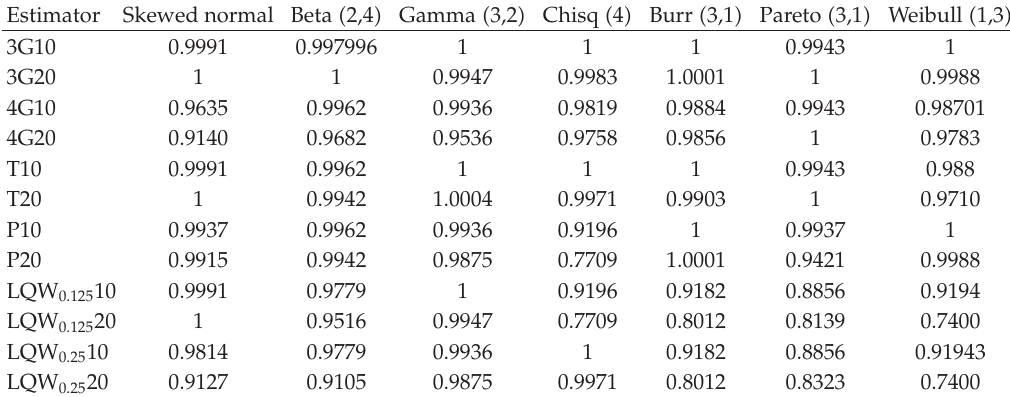
Table 2: Relative mean square